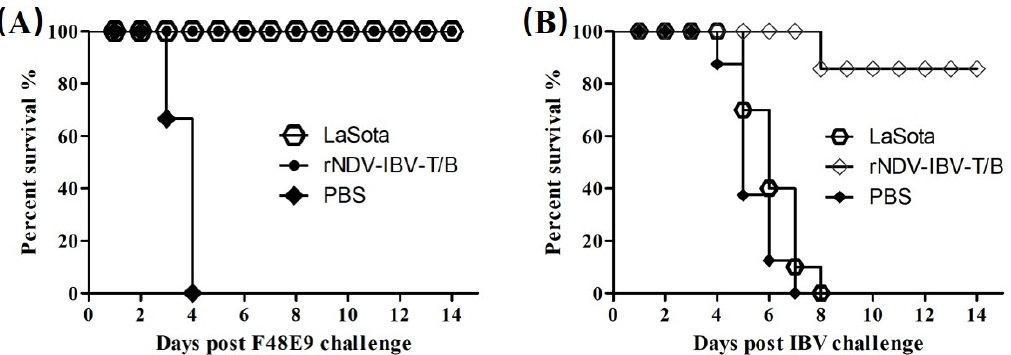
Figure 4. Protective efficacy of vaccines against NDV and IBV challenge. SPF chickens (15 per group) were vaccinated with rNDV-IBV-T/B, LaSota, or PBS. Three weeks post-immunization, chickens were challenged with 10 6 ELD 50 of the NDV F48E9 strain ( A ) and IBV M41 strain ( B ). Symptoms